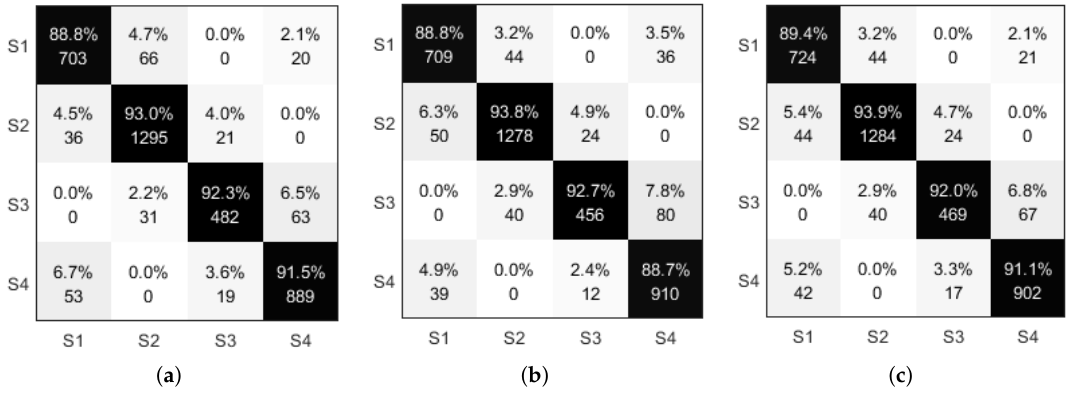
Figure 14. Confusion matrix of the model before and after parameter adaptation ( a ) HMM ( b ) MLLR ( c )